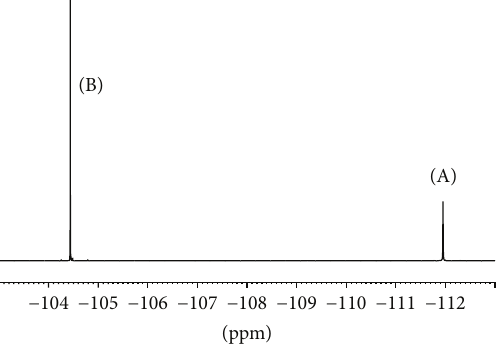
Figure 3: 19 F qNMR spectrum of atorvastatin calcium (A) and internal standard (B).